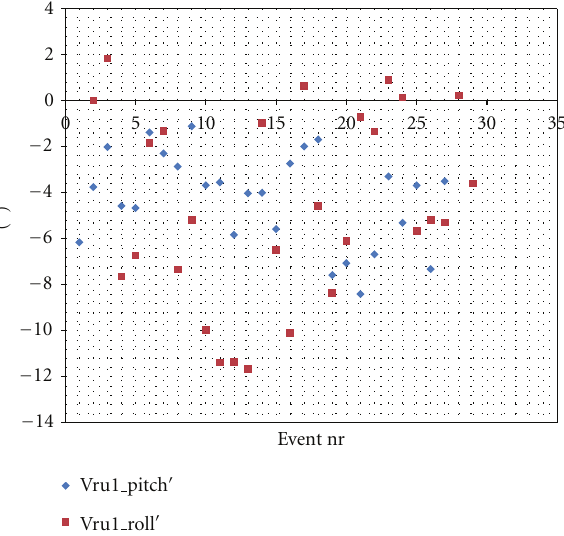
Figure 27: Ship Motions during the events—starboard